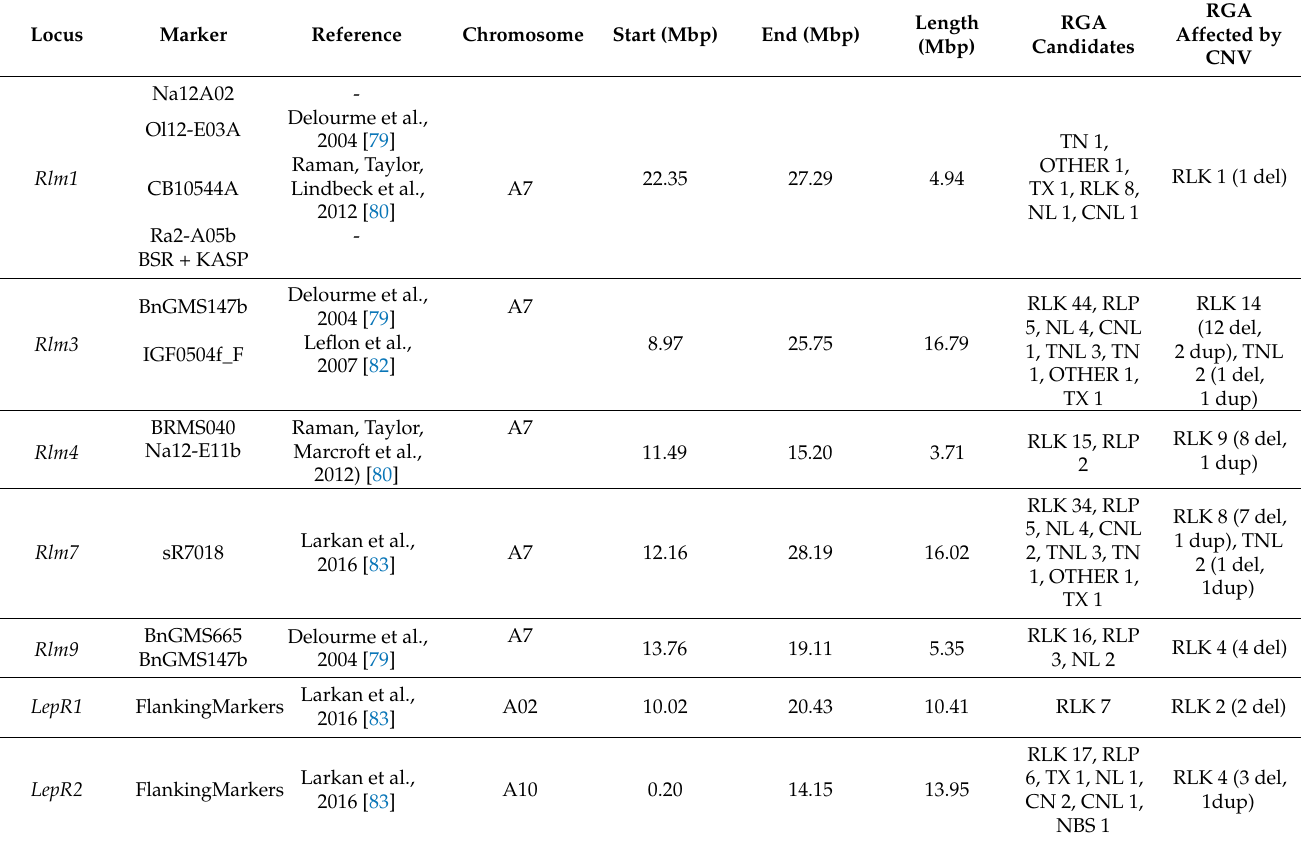
Table 4. RGA candidates and RGA affected by CNV events underlying reported regions for blackleg resistance